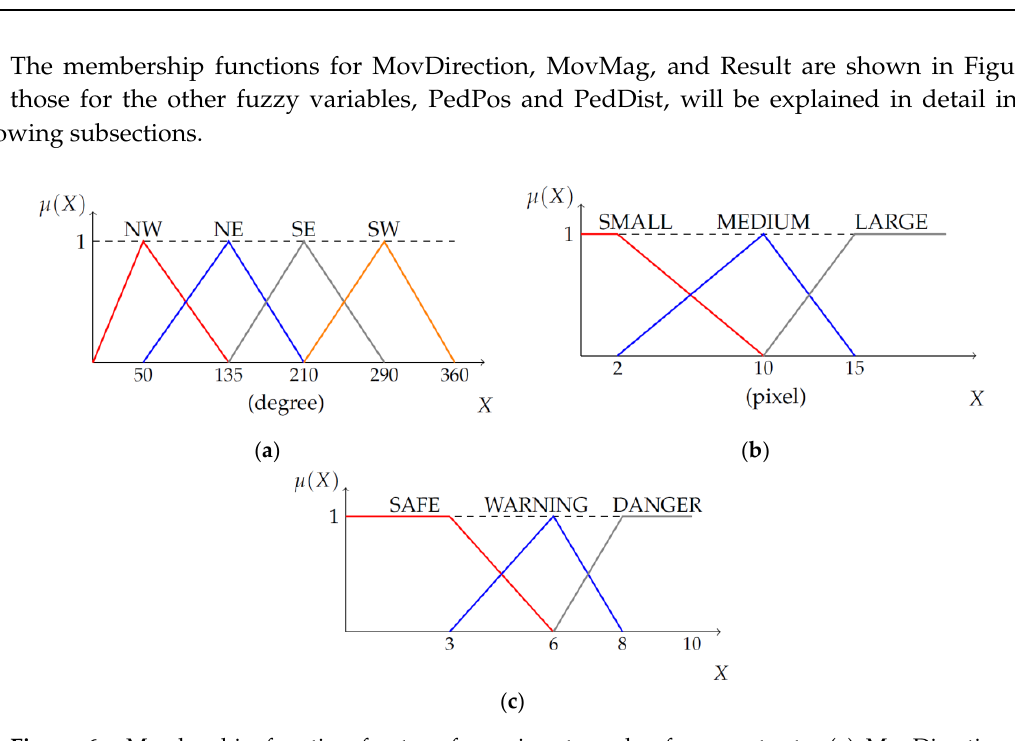
Figure 6. Membership function for two fuzzy inputs and a fuzzy output. ( a ) MovDirection, ( b ) MovMag, ( c ) Result. ( b ) MovMag, ( c )